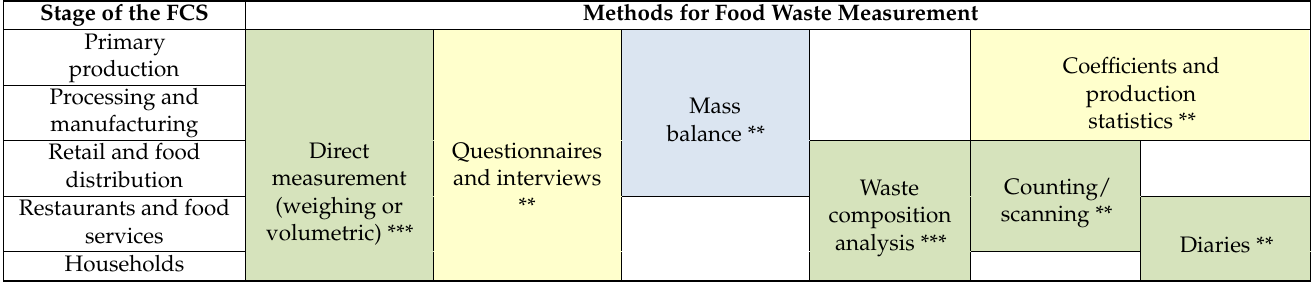
Table 1. Accuracy and reliability (*** high, ** medium) of the food waste measurement methods suggested by the European Commission (adapted based on [46]). Methods for Food Waste